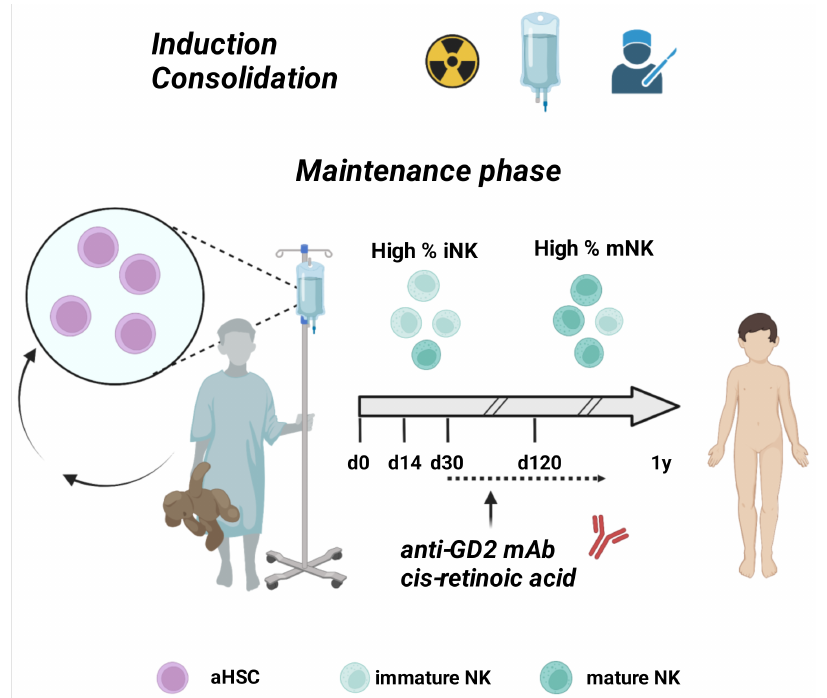
Figure 1. Standard therapy for patients with HR-NB. After chemo-, radio-therapy, and surgical intervention, the maintenance phase consists of autologous HSCT followed by the anti-GD2 im- munotherapy starting from about 30 days post-transplant. At the time of immunotherapy NK cells still have a CD16neg/low KIRneg NKG2Abright immature phenotype (iNK), acquiring only later the CD16pos KIRpos NKG2Aneg mature phenotype (mNK). aHSC, autologous hemopoietic stem cells. Created with